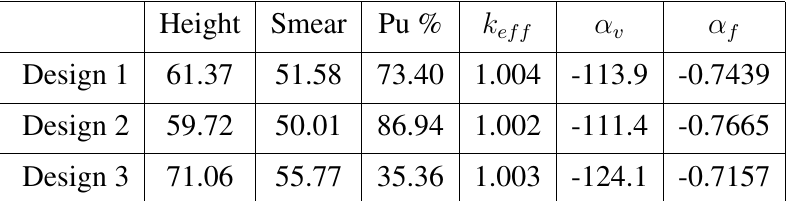
Table 3: Optimal Solutions for SFR Preliminary